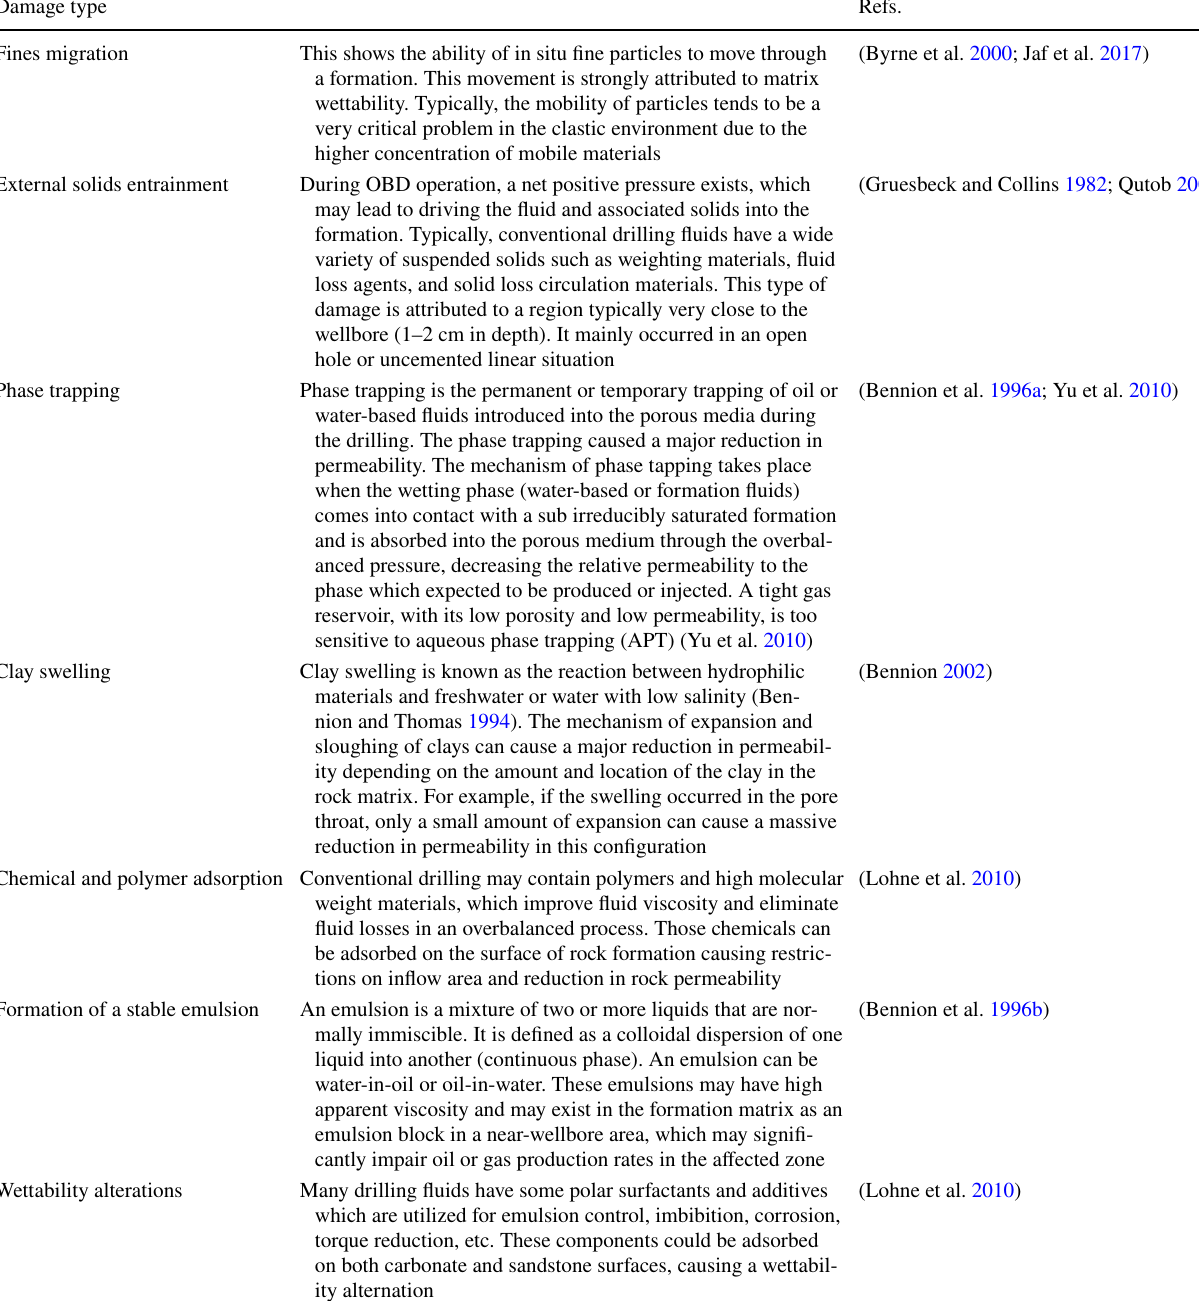
Table 1 A summary of the most common formation damage types that occurred during OBD Damage type